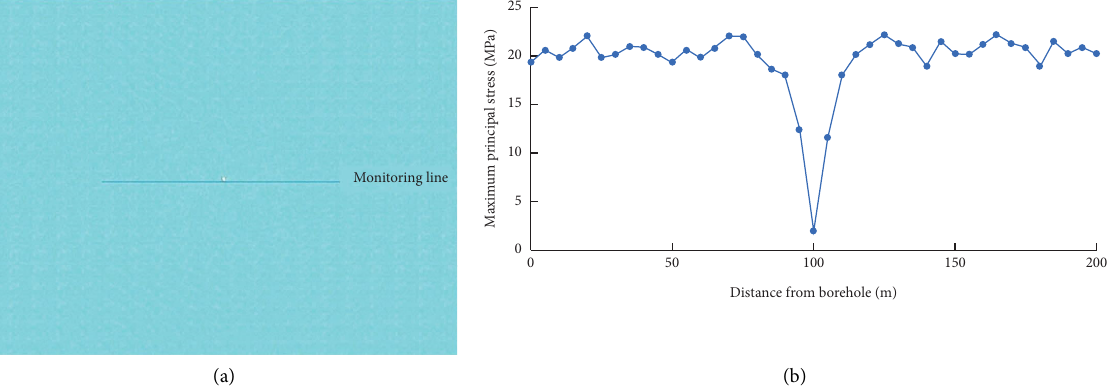
Figure 9: Fracture and stress distribution of coal seam after drilling. (a) Distribution of fractures. (b) Stress distribution condition.